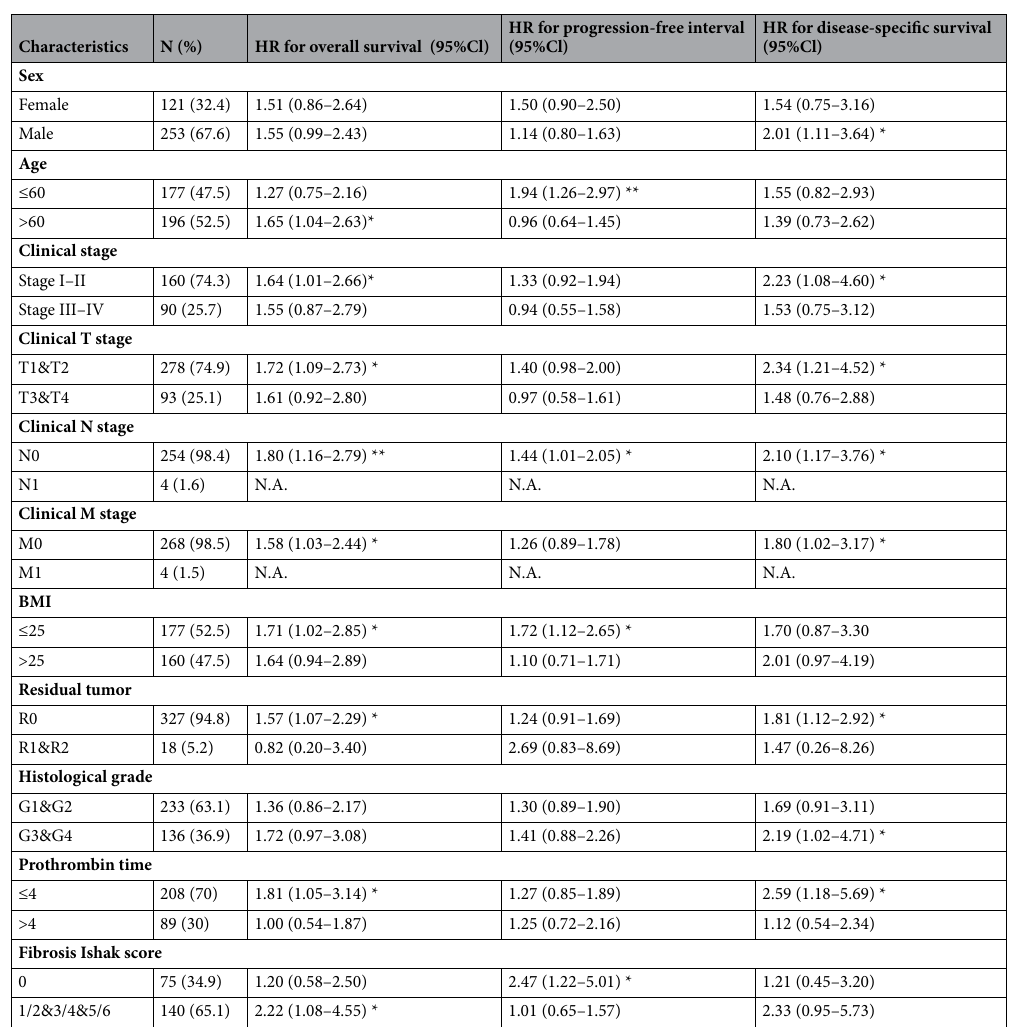
Table 3. Prognostic performance of TBC1D10B on clinical outcomes in LIHC patient subgroup. HR hazard ratio, Cl confidence interval. *P < 0.05; **P <